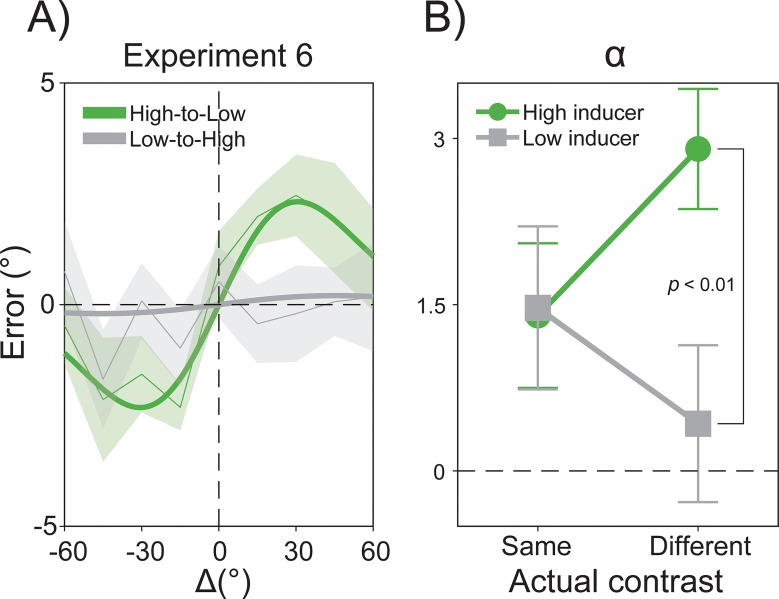
Results of Experiment 6.(A) High-contrast inducer stimuli increased the impact of previous decisions on the processing of low-contrast stimuli. (B) The interaction Inducer Contrast × Actual Contrast. The raw data are available at https://doi.org/10.5281/zenodo.2544946.